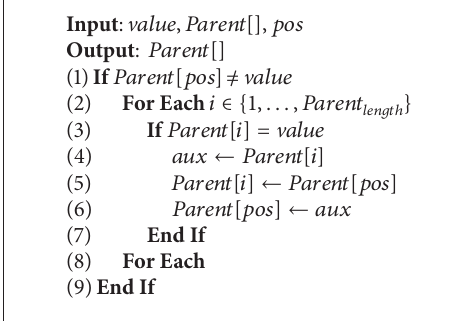
Algorithm 4: Swap.